Question: What caption would you write for this figure?
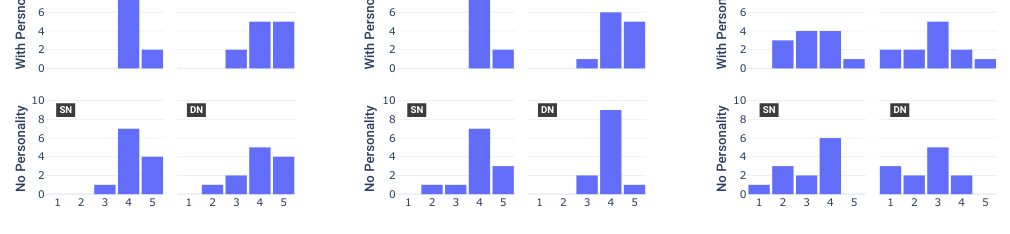
Answer: summarizes the distribution of participants for rating (1) the ability to understand, (2) the ability to acknowledge user input, and (3) the level of empathy. The Kruskal-Wallis tests showed